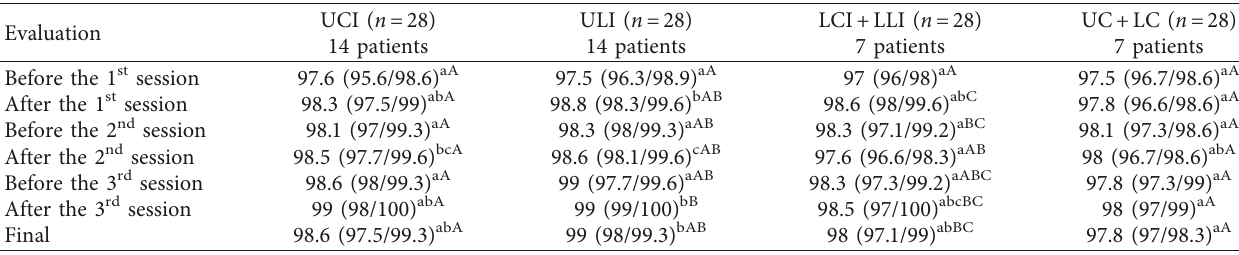
and adjusted multiple comparisons, P > 0 . 05. UCI: upper central incisor; ULI: upper lateral incisor; LCI: lower central incisor; LLI: lower lateral incisor; UC: upper canine; LC: lower canine. Table 5: The Spearman correlation value for SpO 2 p data and color change ( Δ E ) data measured at different periods. SaO 2 p reading median (first/third